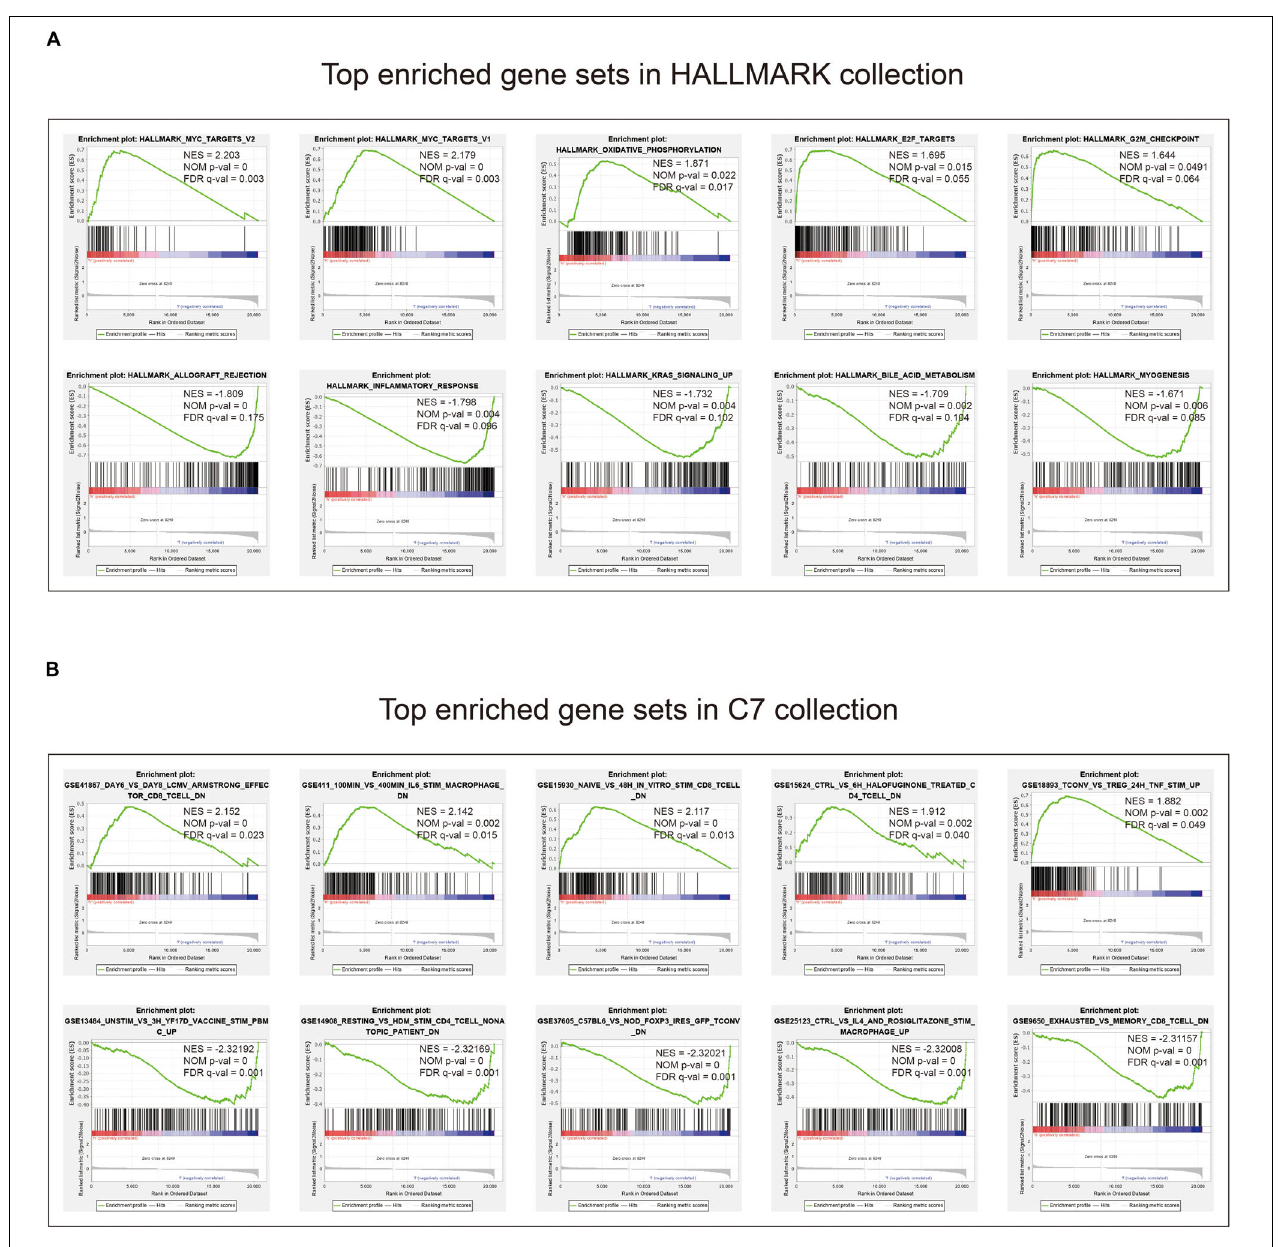
FIGURE 7 | Gene set enrichment analysis. (A) Top enriched gene sets annotated by the HALLMARK collection between the high- and low-risk groups in the training cohort. (B) Top enriched gene sets annotated by the C7 collection between the high- and low-risk groups in the training cohort. Only gene sets with | NES| > 1, NOM p -val < 0.05, and FDR q -val < 0.25 were considered